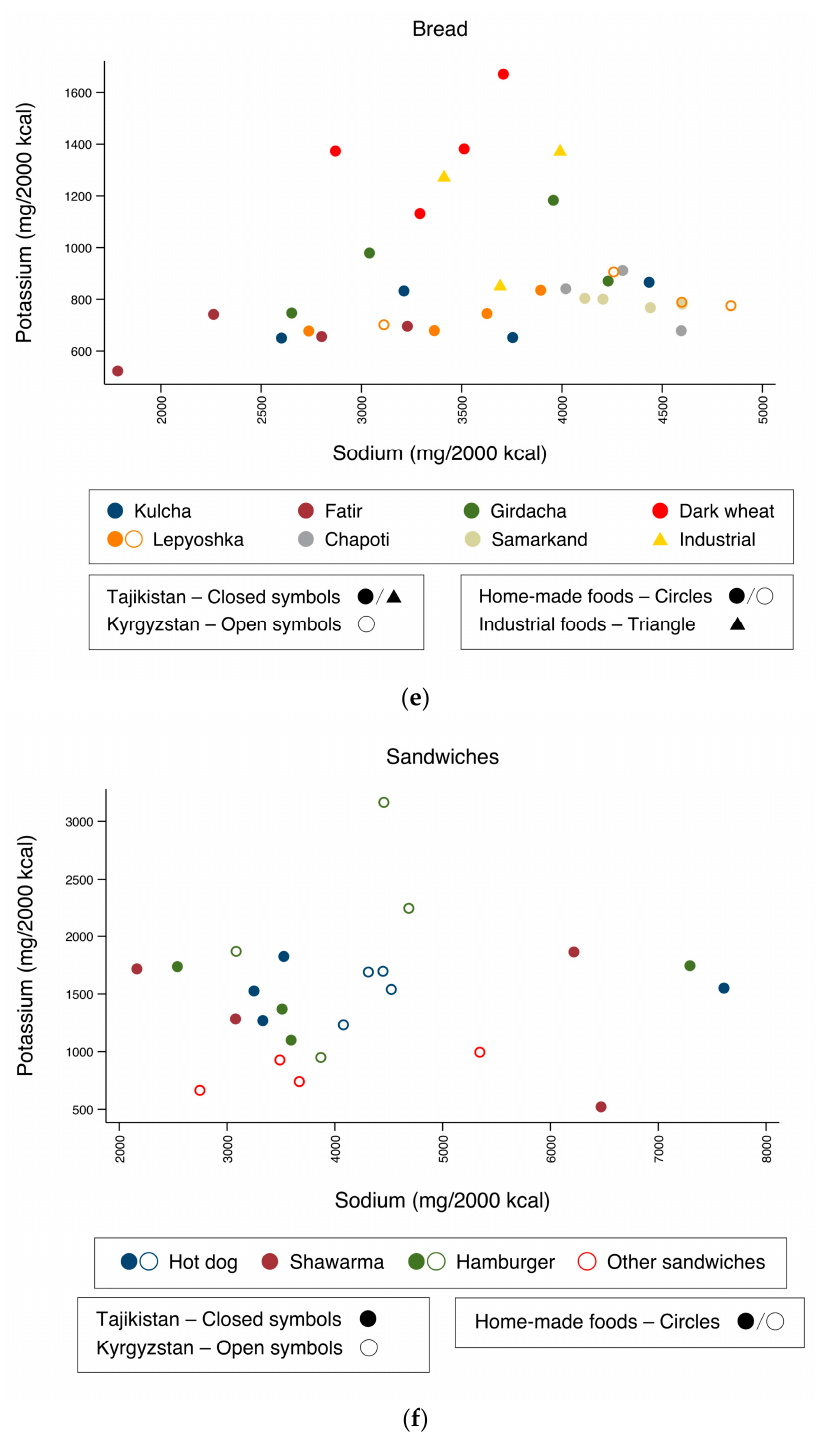
Figure 4. Distribution of individual sodium and potassium contents (mg/2000 kcal) of each of the samples collected for the most commonly available home-made and industrial foods assigned to six of the eight different predefined groups: ( a ) savoury pastries; ( b ) snacks; ( c ) cakes and cookies; ( d ) main dishes; ( e ) bread and ( f ) sandwiches. Closed symbols represent Tajikistan and open symbols represent Kyrgyzstan; circles indicate home-made foods and triangles indicate industrial foods.